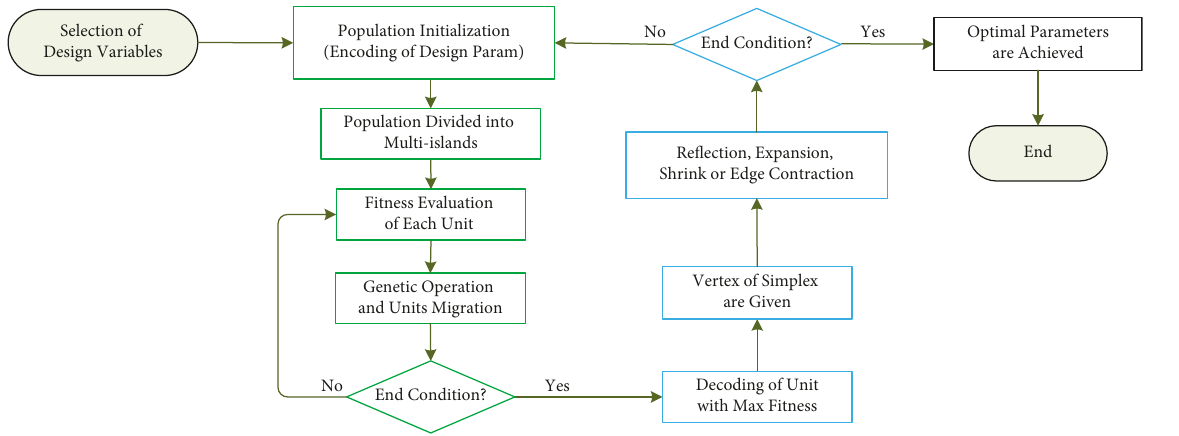
Figure 3: The flowchart of the hybrid optimization.